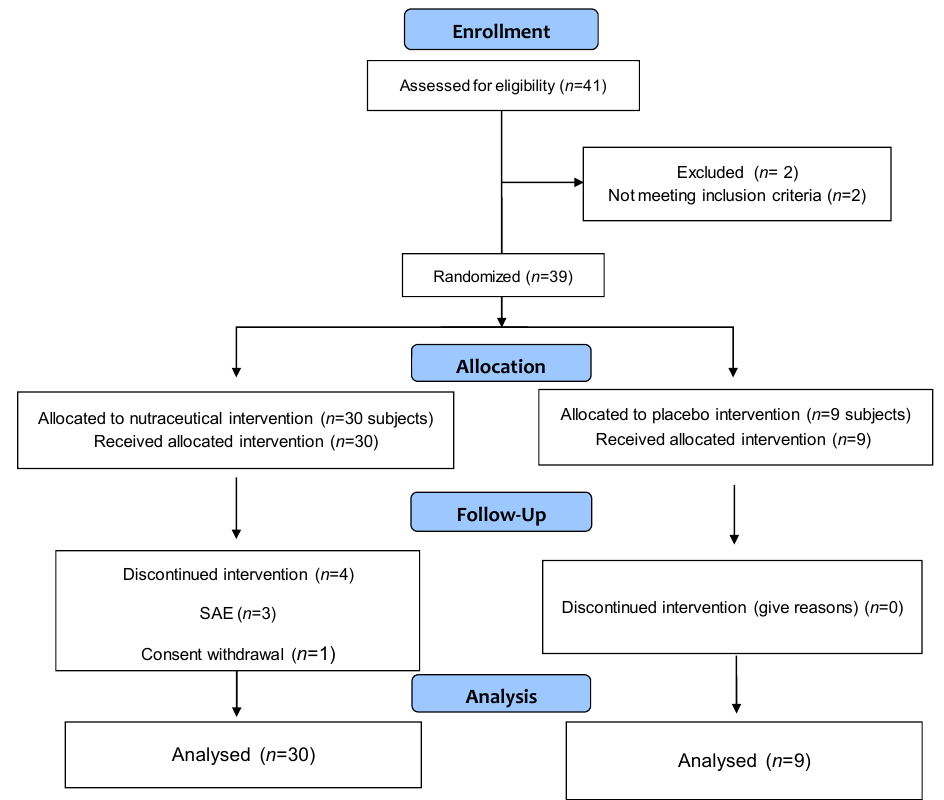
Figure 1. Study Consort diagram. Consort flow-chart according to the intention-to-treat analysis of the study. (SAE: severe adverse event). Table 1. Baseline characteristics of study subjects.